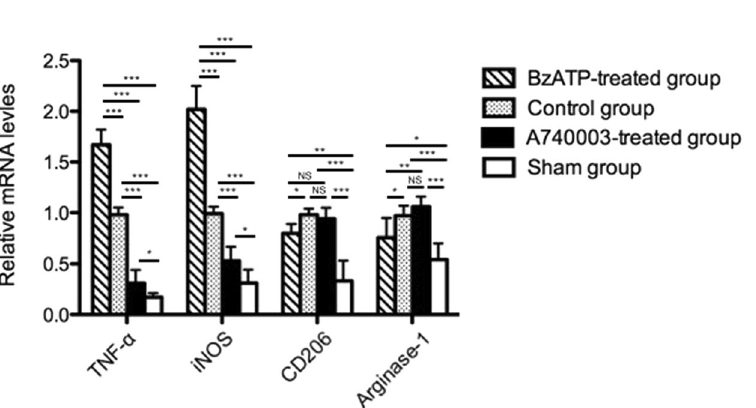
Figure 7. The effects of a P2X7R blockade on macrophage markers. The mRNA levels of M1-associated genes (TNF- α and iNOS) and M2-associated genes (CD206 and Arginase-1) in intestinal mucosa determined by quantitative PCR at 48 hours after CLP. N = 6 mice per group. The results are expressed as the means ± SD of three independent experiments. * p < 0.05, ** p < 0.01 and *** p < 0.001 when compared among the different